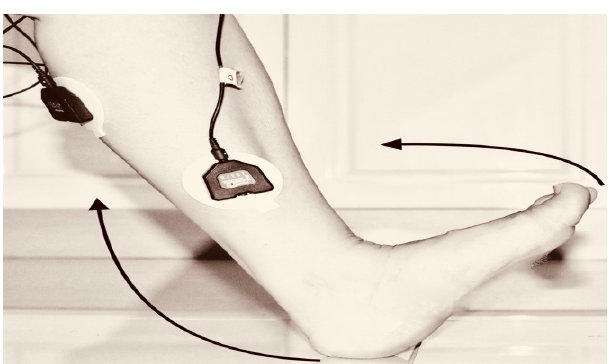
Figure 6. Knee Flexion with Flexion Dorsiflexion.